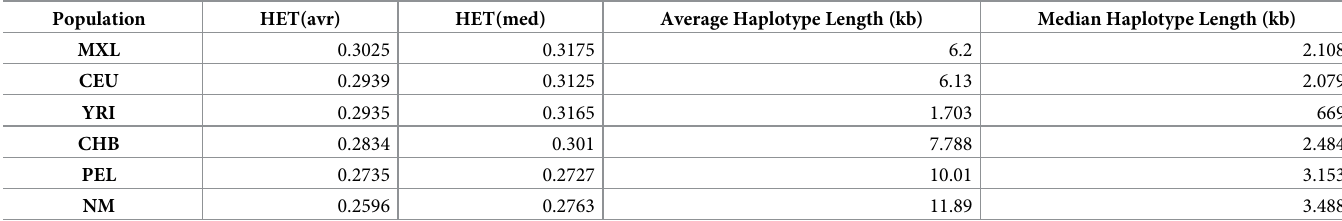
Table 2. Heterozygosity ratio and haplotype block length per